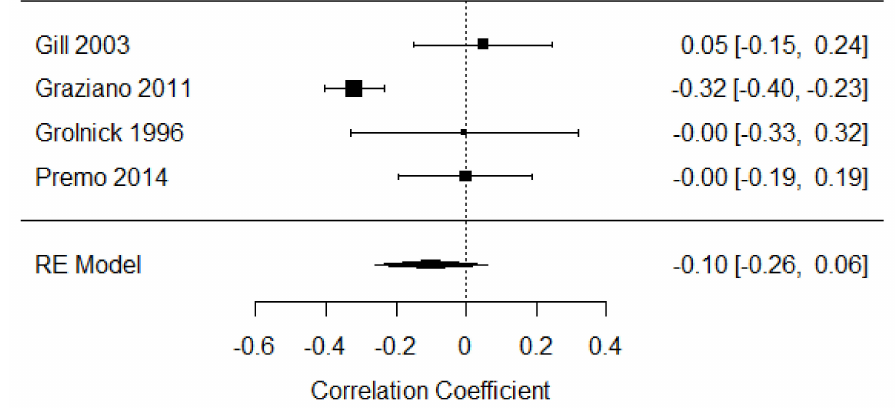
Figure 11. Forest plot of year 3 self-soothing strategies. Note: RE = Random-Effects